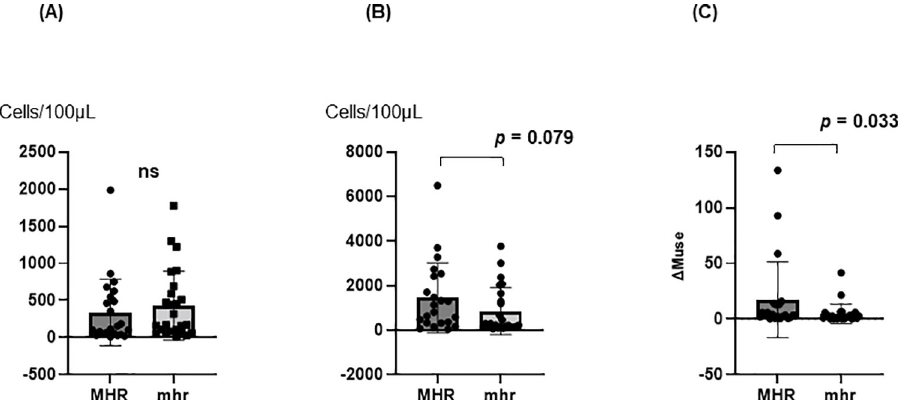
Fig 4. Comparison of MHR and mhr. A: The number of PB-Muse cells before surgery. B: Max PB-Muse in the MHR and mhr groups. C: Δ Muse in the MHR groups and mhr group. Max. Muse = maximum PB-Muse cell number on PODs 3 and 7.